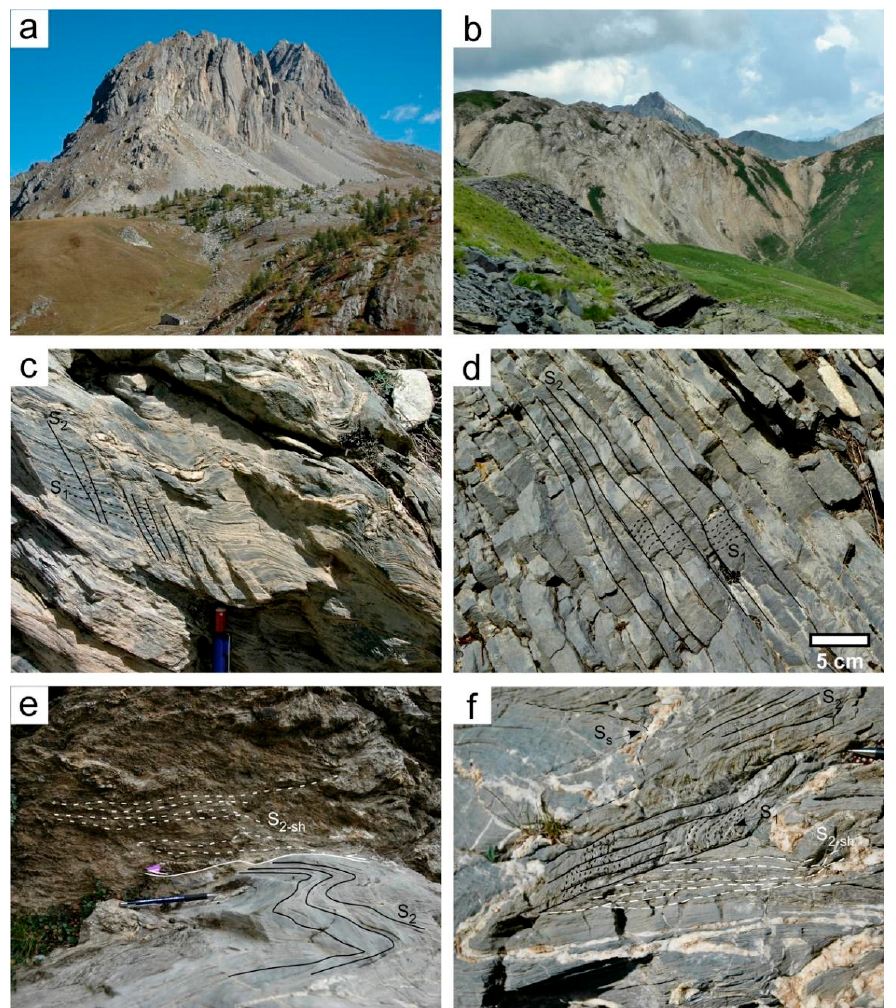
Figure 7. ( a ) The sub-vertical Triassic dolostone succession of Rocca la Meja (Meja unit, GVZ, Gardetta highland). In the foreground (right lower corner) an outcrop of steepened Lower Triassic quartzarenite of the Gardetta Deformation Zone is visible. ( b ) Intensively folded and steepened gypsum within the Gardetta Deformation Zone. ( c ) Upper Cretaceous marly limestones in the external part of the GVZ (Dauphinois-Provençal succession) close to the Tenda pass showing a well-developed spaced crenulation cleavage (S2, black lines), crosscutting the older S1 foliation (black dashed lines). Note that in this area the S2 is NE-dipping. ( d ) Upper Cretaceous marly limestone in the External Briançonnais M. Omo Unit, close to Valcavera pass showing a well-developed spaced crenulation cleavage (S2, black lines), crosscutting the S1 foliation (black dashed lines). ( e ) Strain localization along the lithological contact between Upper Cretaceous marly limestone (Upega Fm.) and Upper Jurassic grey limestone (M. Marguareis, Ligurian Briançonnais domain). The S2 spaced cleavage (black lines) is dragged by S2-shear planes (S2-sh, white dashed lines) developed during the late stages of D2 and probably also during the D3 phase. ( f ) Upper Cretaceous marly limestones of the External Briançonnais succession in the Limone-Viozene Zone, Marguareis area. A well-developed spaced crenulation cleavage (S2, black lines) was generated as axial planar surfaces of F2 folds that folded both bedding and older foliation S1 (black dashed lines). Locally, S2 surfaces evolved from an axial plane foliation to a slip cleavage (S2sh, white dashed lines), giving origin, in some places, to dm-thick shear zones, which reoriented all the pre-existing foliations.